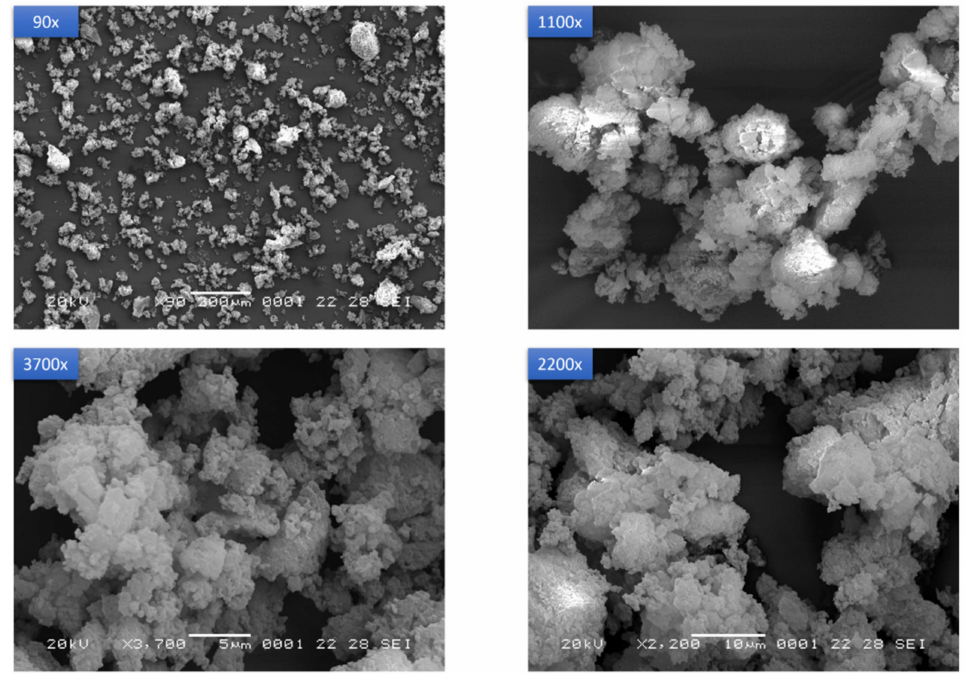
Figure 9. SEM images of PZQ-HH powder at di ff erent magnifications (90 × , 1100 × , 2200 × and 3700 ×